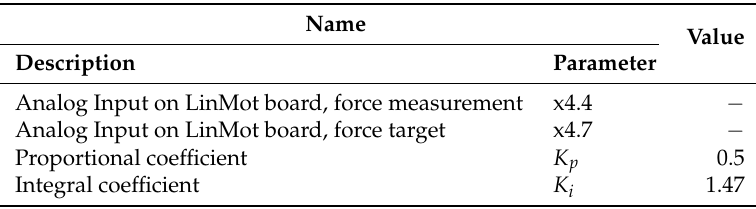
Table 1. LinMot set-up description and controller